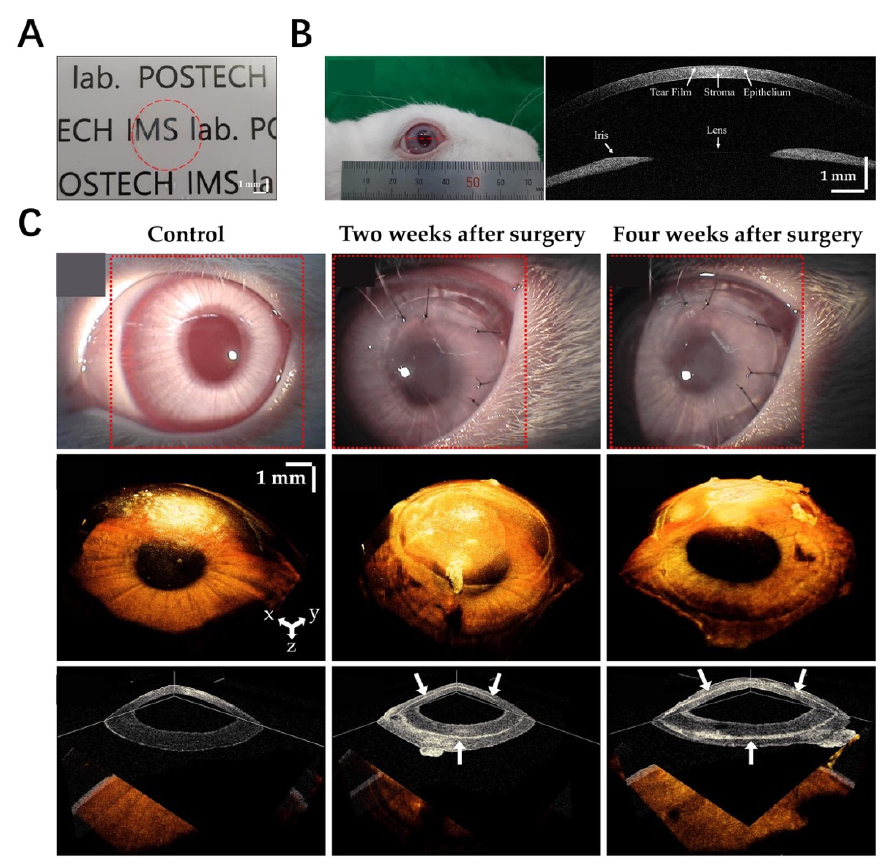
Figure 10. ( A ). 3D-bioprinted decellularized collagen sheet [185] . ( B ). In vivo implantation experi- Figure 10. ( A ) 3D-bioprinted decellularized collagen sheet [185]. ( B ) In vivo implantation experi- ment [185] . ( C ). Slit-lamp microscopic images [185] . ment [185]. ( C ) Slit-lamp microscopic images